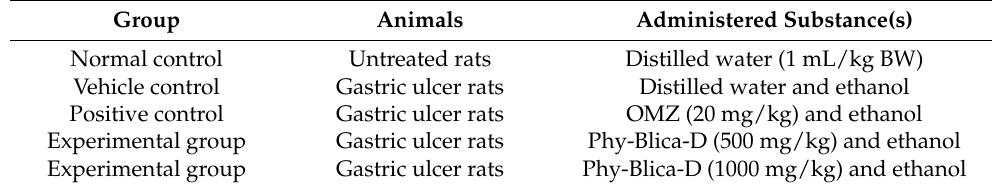
Table 2. Experimental design. Phy-Blica-D was administered as a pretreatment for 7